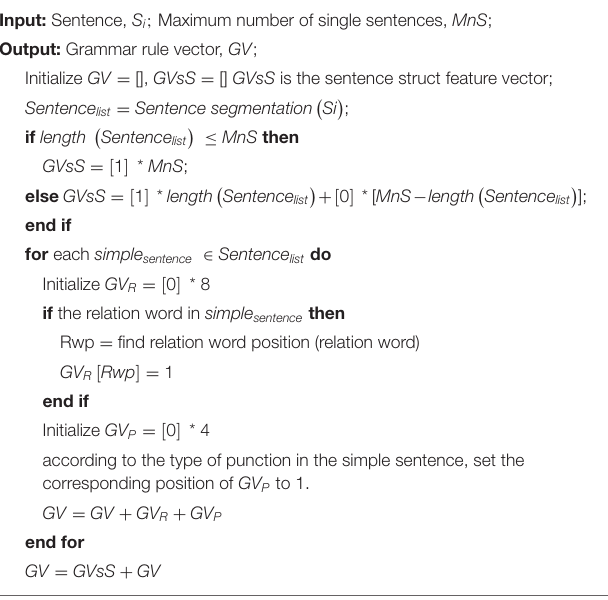
TABLE 1 | The statics of the datasets.